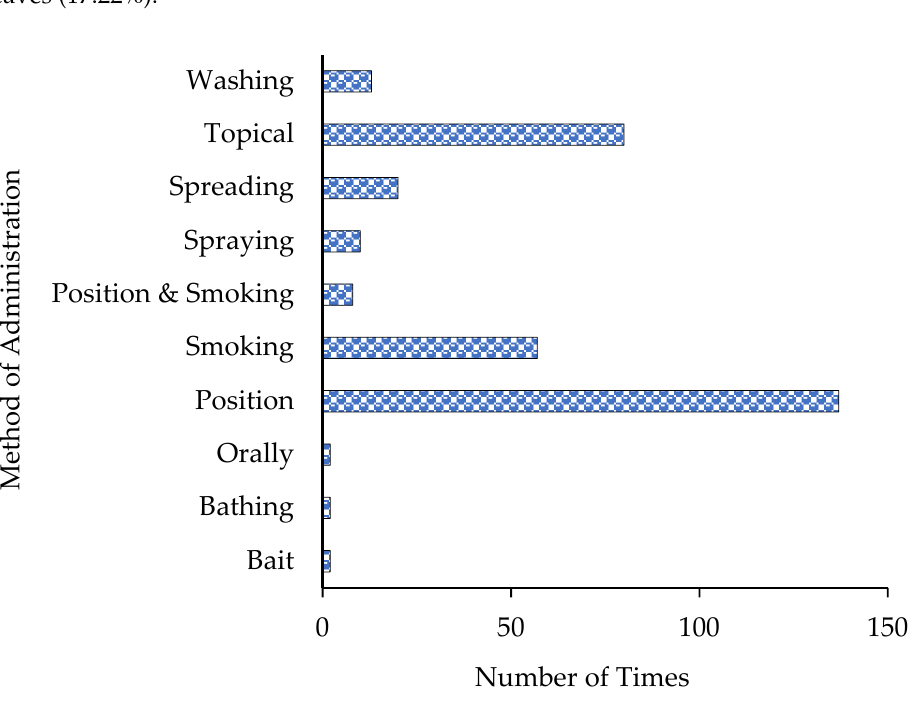
Figure 4. Frequency of mode of application of plants for pest management.